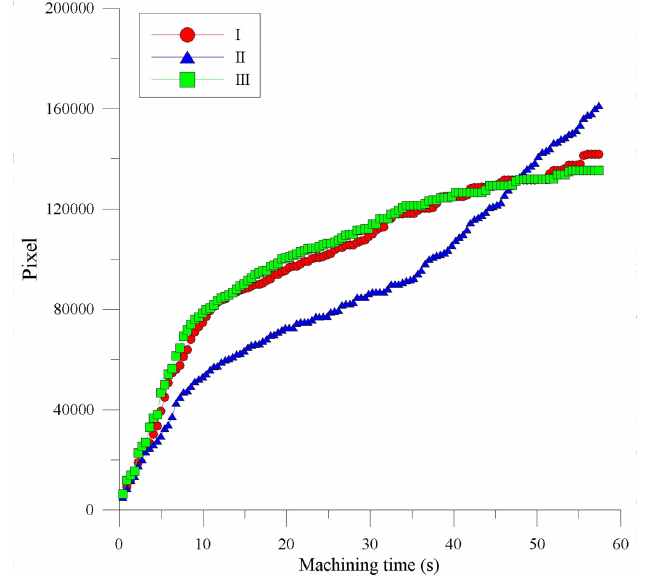
Figure 8. The accumulated light emission pixels of the SACE-drilled holes, acquired by using a coaxially mounted industrial camera.